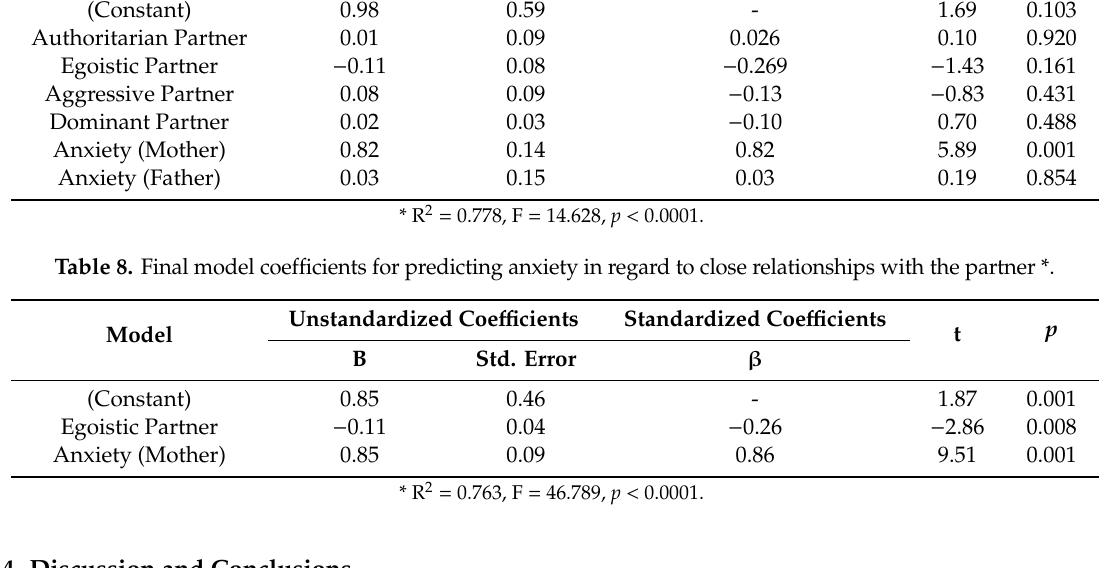
Table 7. Full model coe ffi cients for predicting anxiety in regard to close relationships with the partner *. Model